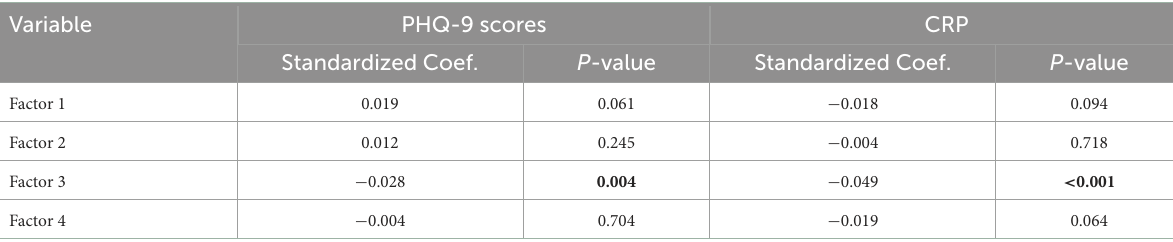
TABLE 4 Multiple linear regression of 4 factors with PHQ-9 scores and CRP.